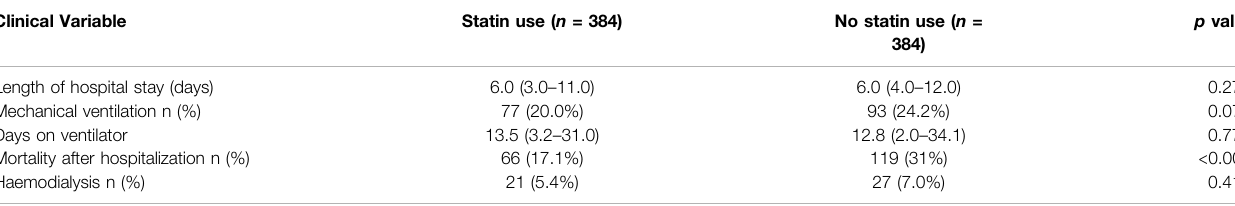
TABLE 4 | Clinical outcome in propensity matched cohorts. Clinical Variable